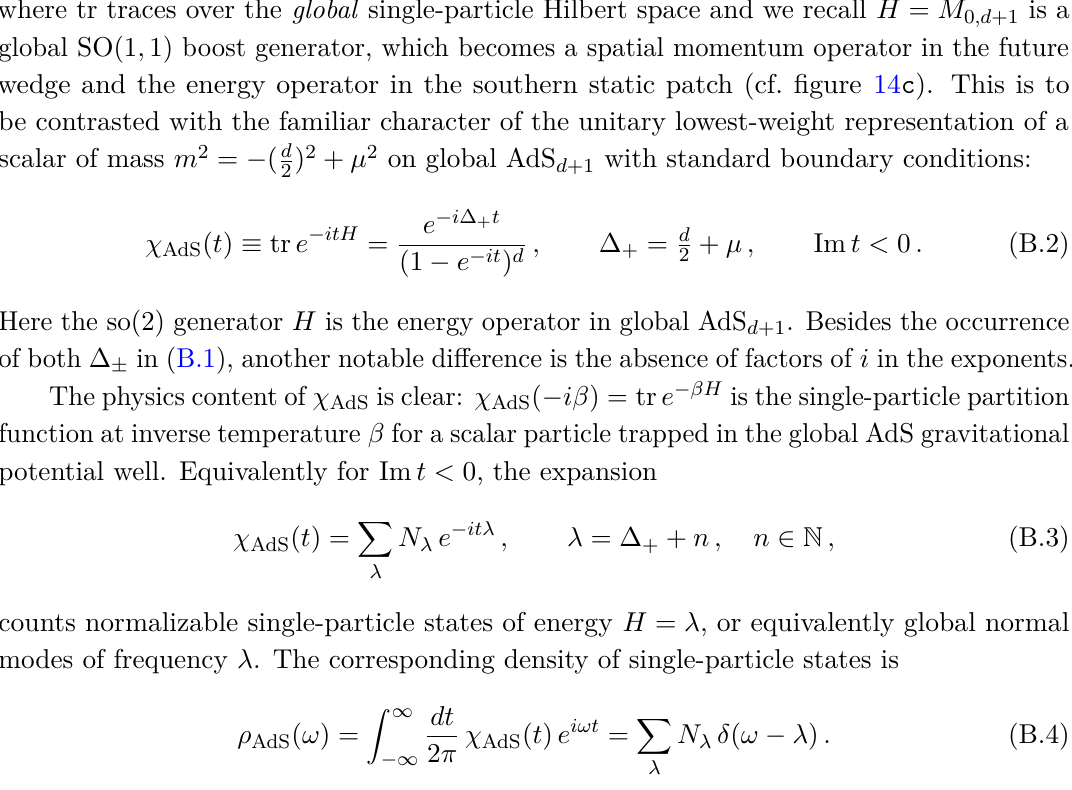
Figure 10 . Density of states ρ Λ ( ω ) for dS 3 scalars with ∆ = 1 + 2 i , ∆ = 1 Λ = 100 , according to (B.7). The red dotted line represents the term 2Λ /π . The peak visible at ∆ = 1 is due to a resonance approaching the real axis, as explained in section 10